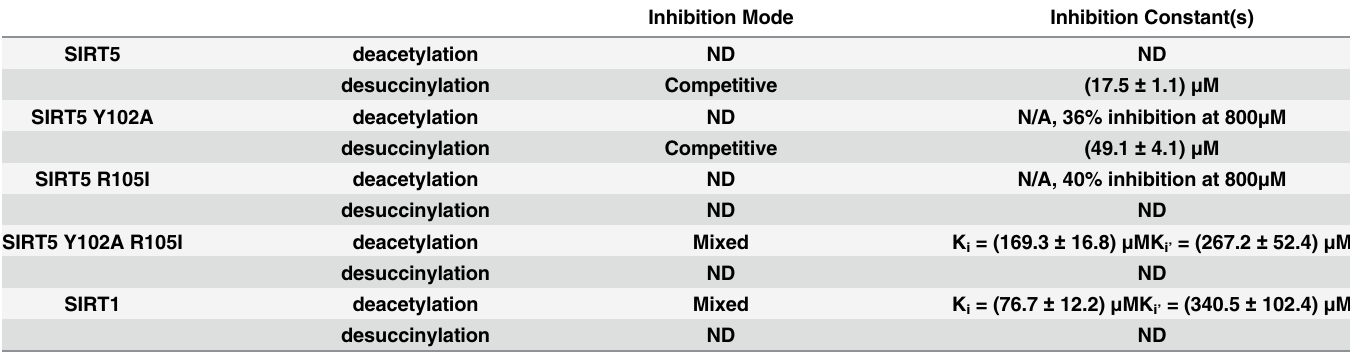
Table 3. Nicotinamide Inhibition against SIRT5 Variants and